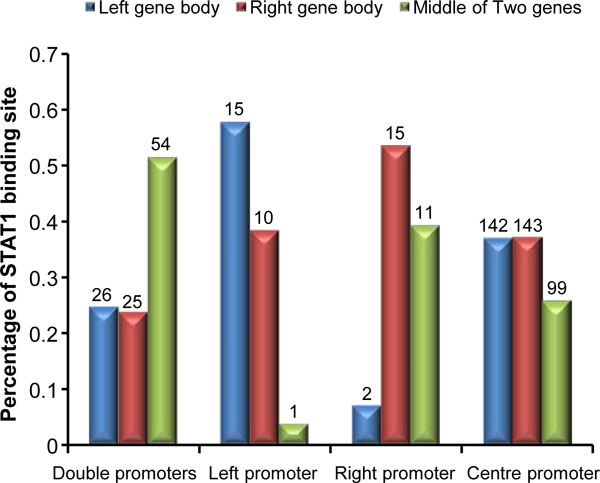
Percentage of STAT1 binding sites associated with 4 types of promoters. The blue, red and green colors correspond to STAT1 binding sites located in the left, the right and the middle of 2 genes, respectively. The numbers on the top of bars represent the total STAT1 binding sites.